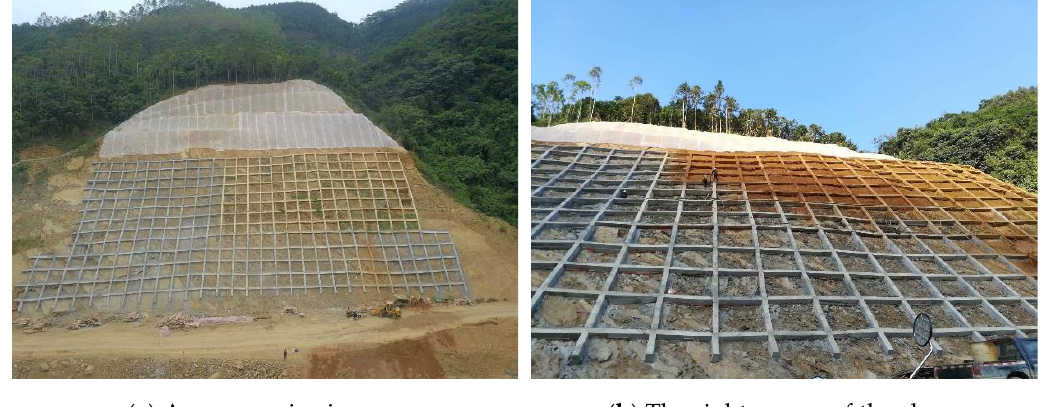
Figure 14. Before Figure 14. Before construction.